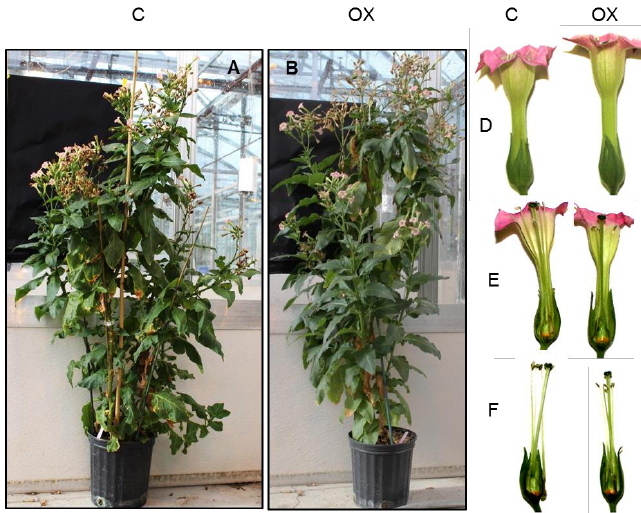
Figure 1. Panel A : Control (C), Panel B : transgenic tobacco (OX) plants that express Solanum lycopersicum phosphatidylinositol 3-kinase-Green fluorescent protein (PI3K-GFP) grown in a greenhouse. Panel D : Flowers from C and OX, Panel E : Cross section of flowers from C and OX, Panel F : Pistil and stamen of flowers from C and OX.